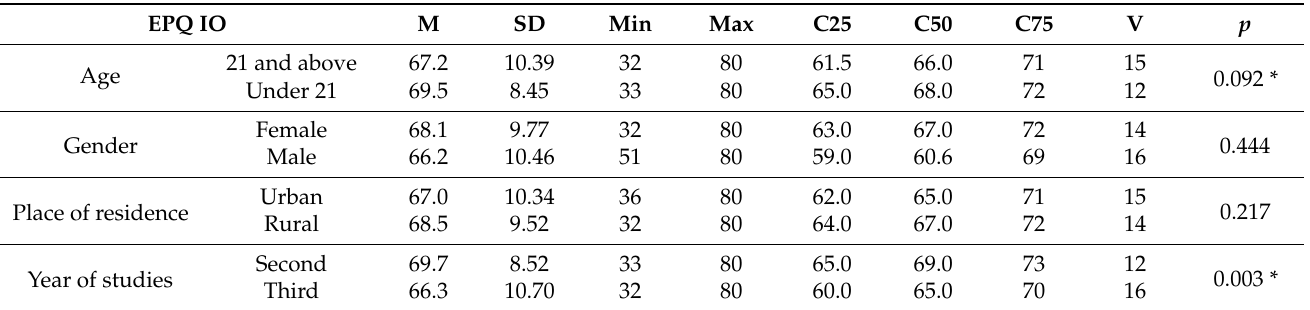
Table 8. Numerical characteristics of results for EPQ-IO subscale in terms of socio-demographic